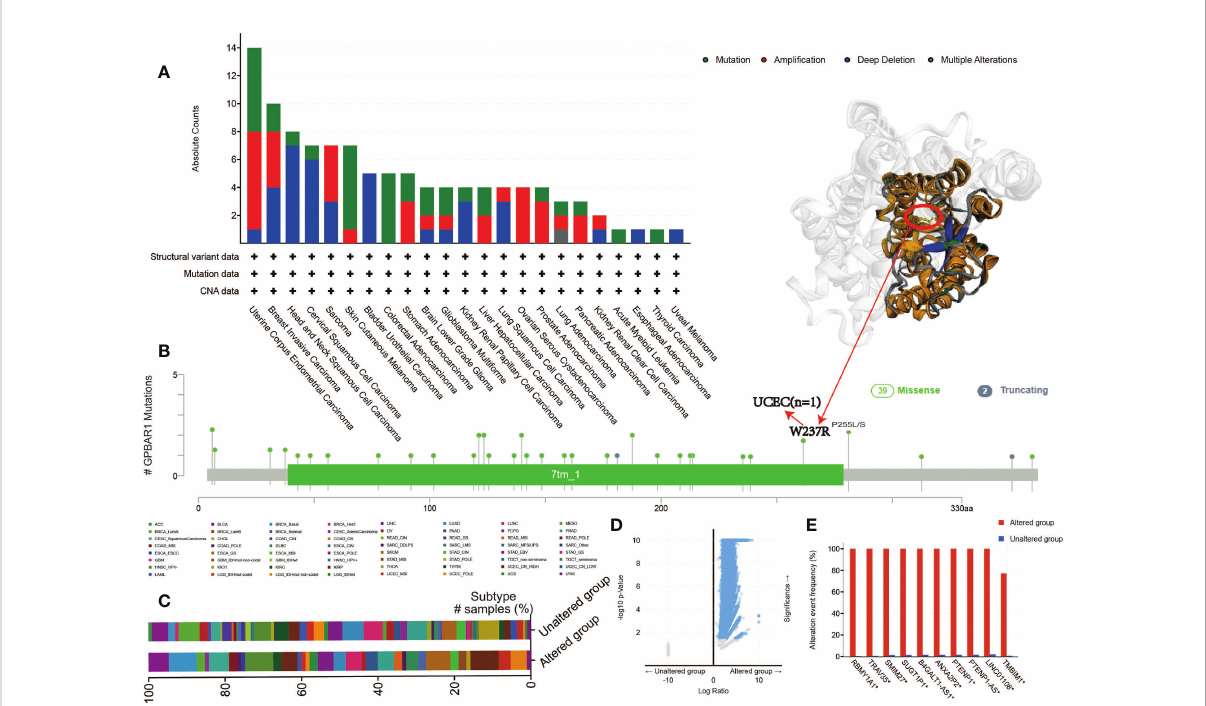
FIGURE 5 The mutation status of the GPBAR1 gene expression level in all TCGA tumors from the cBioPortal tool. The absolute count with mutation type (A) and mutation site (B) is presented. (C – E) Clinical outcomes (C) and genomic changes (D, E) in GPBAR1 gene alteration have also been